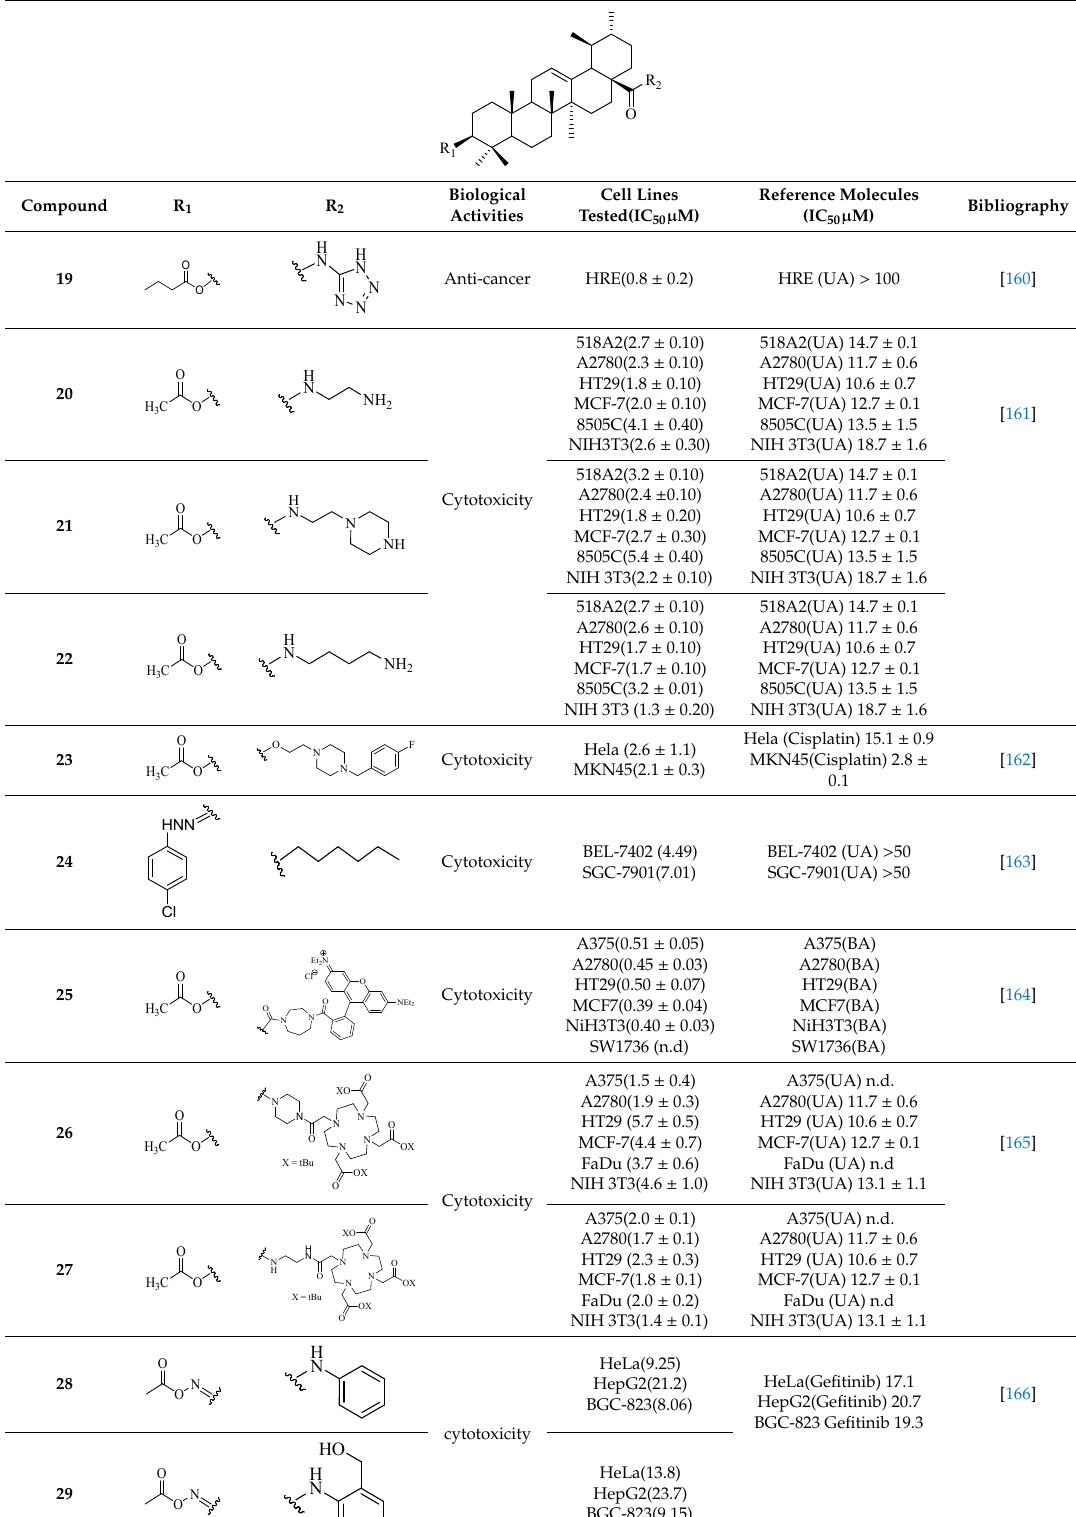
Table 4. Cont. Table 4. Modification of C-3 and C-28